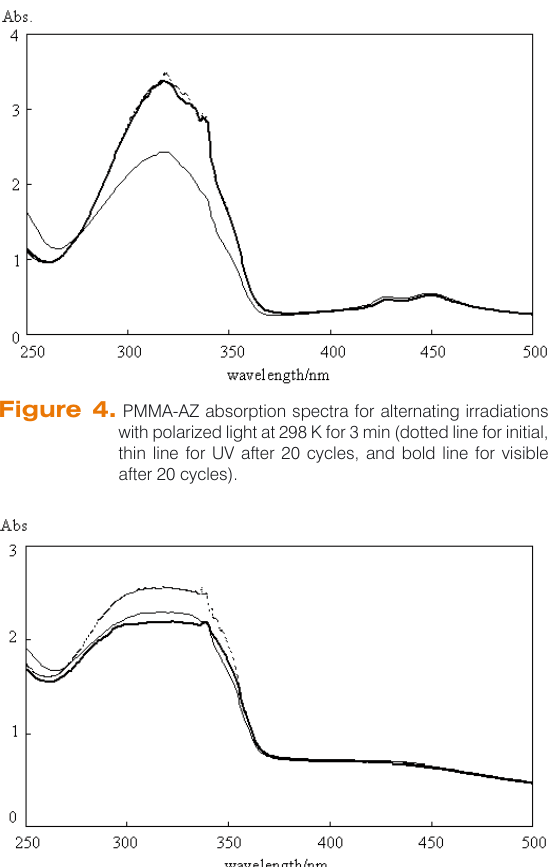
and PMMA-DR1-Mn 12